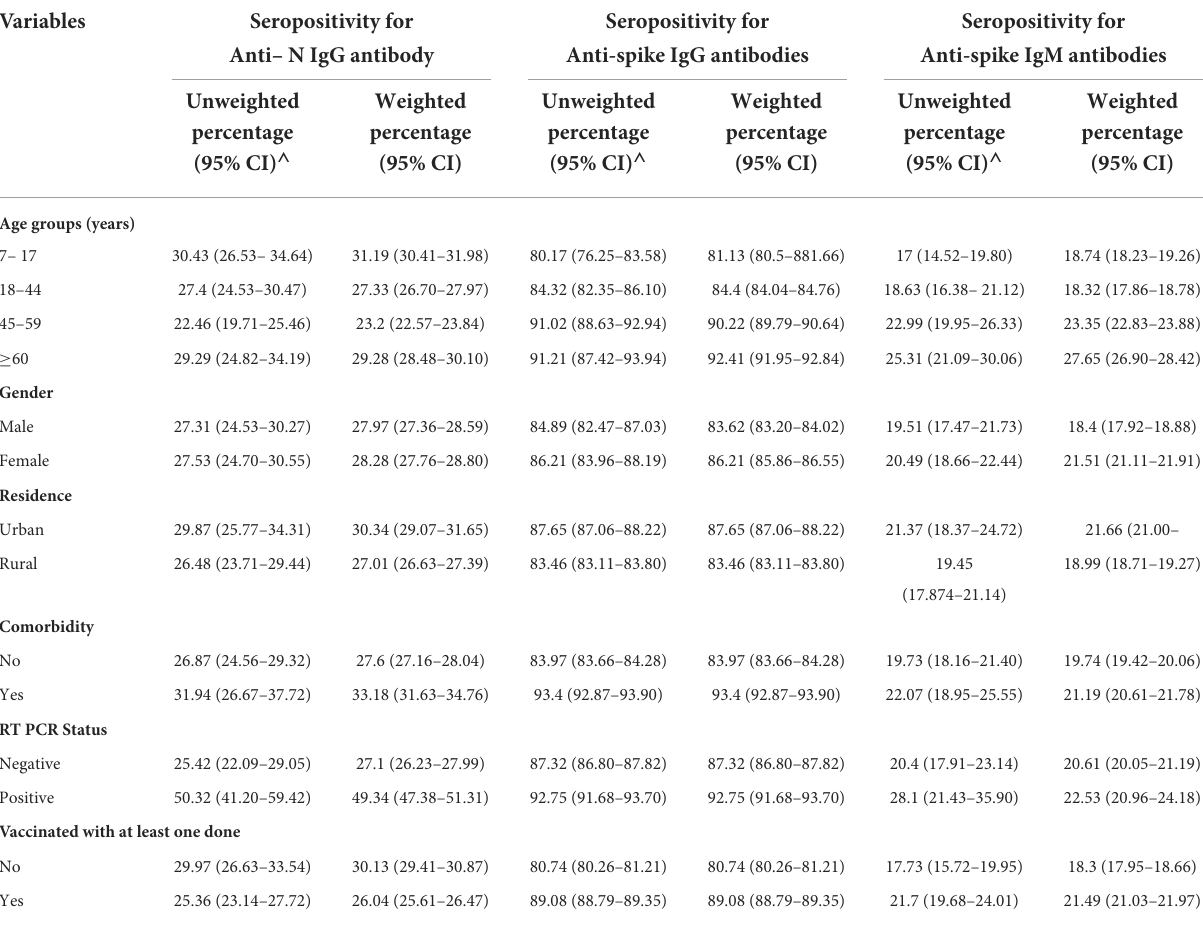
TABLE 2 Seroprevalence (unweighted and weighted) of the complete cases by selected